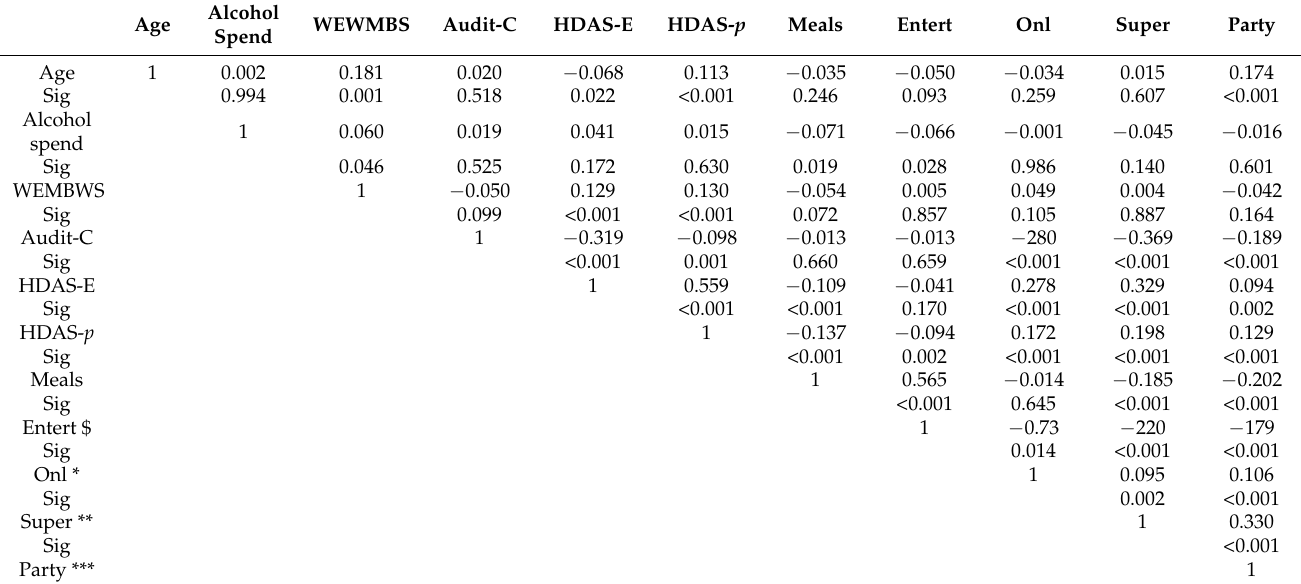
Table 3. Correlations of continuous study variables during